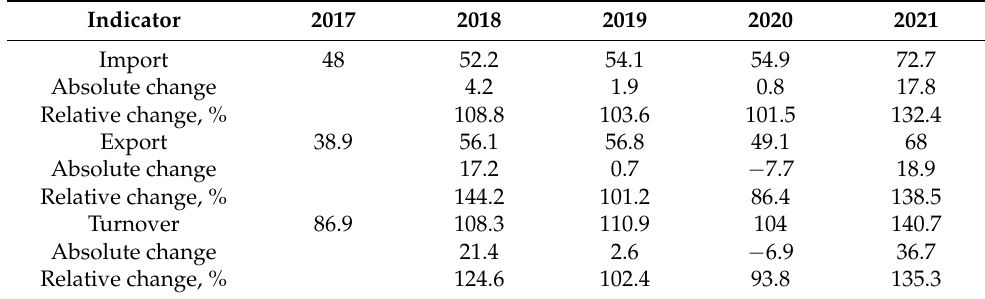
Table 6. The volume of foreign trade of the Russian Federation with China, 2017–2021, billion dollars [46].